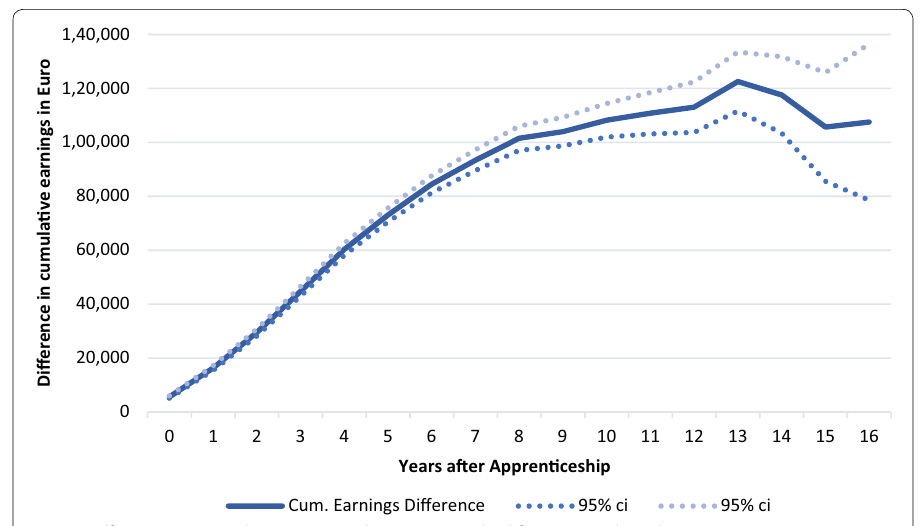
Fig. 4 Differences in cumulative earnings between matched foremen and academics (N